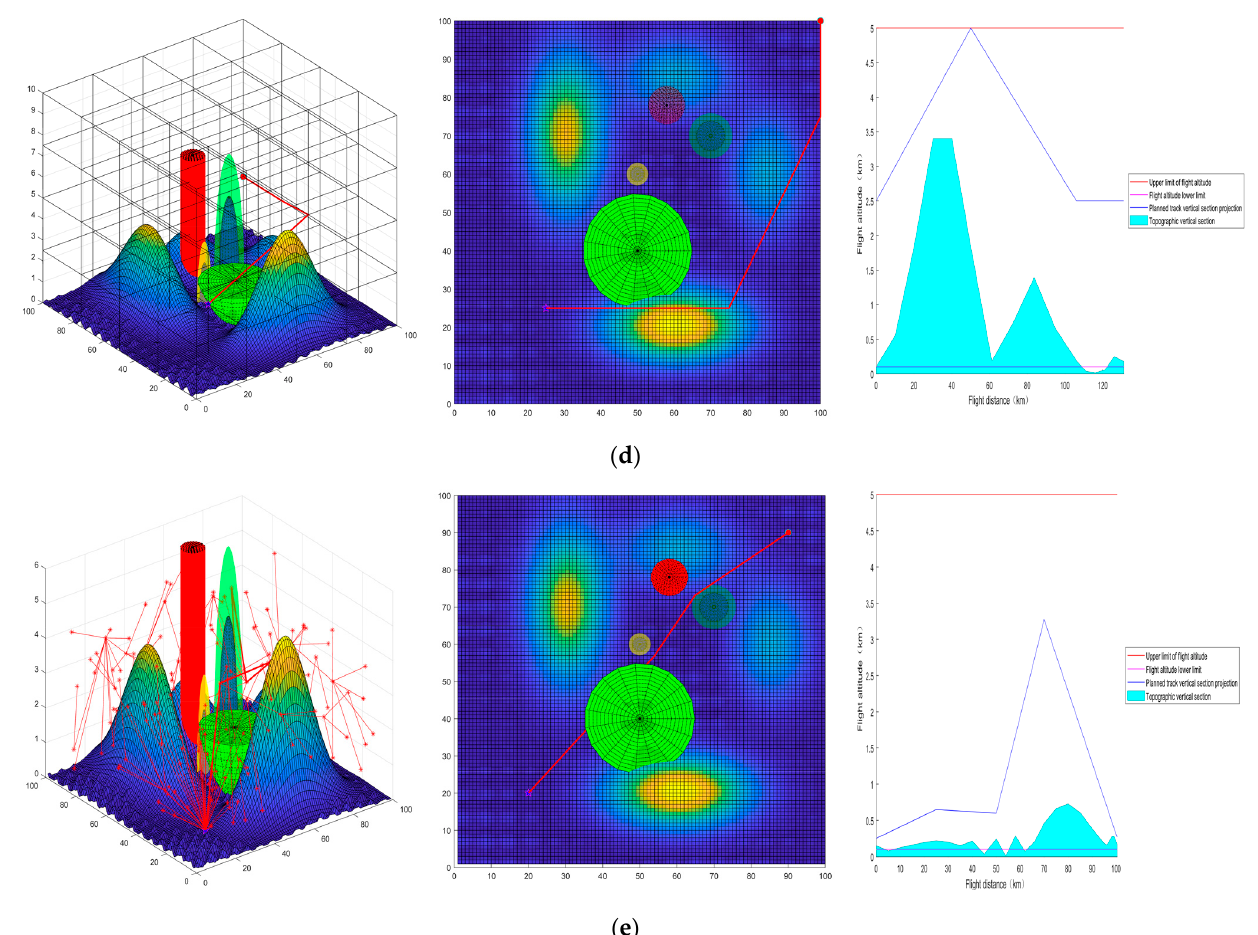
Figure A2. When N = 3, the comparison experiment of the route planning algorithm’s planning result, top view, and altitude change curve. ( a ) Grid-based route planning with the A* algorithm, ( b ) A* algorithm route grid point-based planning, ( c ) Grid-based route planning with Lazy Theta* algorithm, ( d ) Grid point-based Lazy Theta* route planning, and ( e ) RRT* route planning using 25-steps. (2) N = 4 For a grid level of 4, the route planning effect is illustrated in Figure A3.